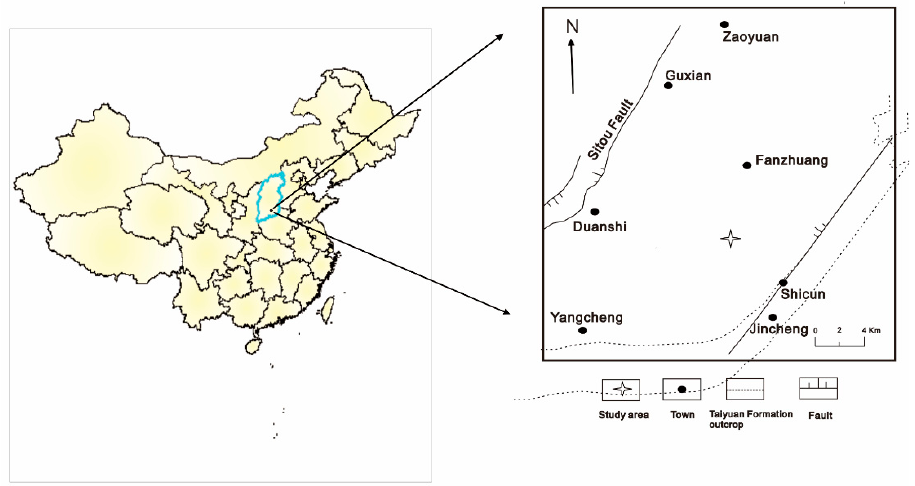
Figure 13. Location ( left ) and geological outline ( right ) of the southern Qinshui Basin.